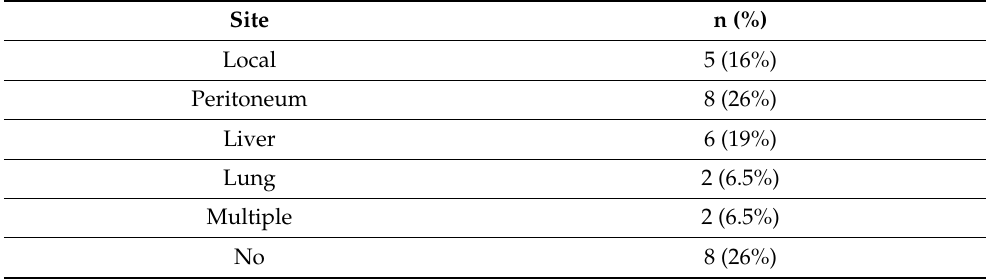
Table 5. Anatomical sites of the first